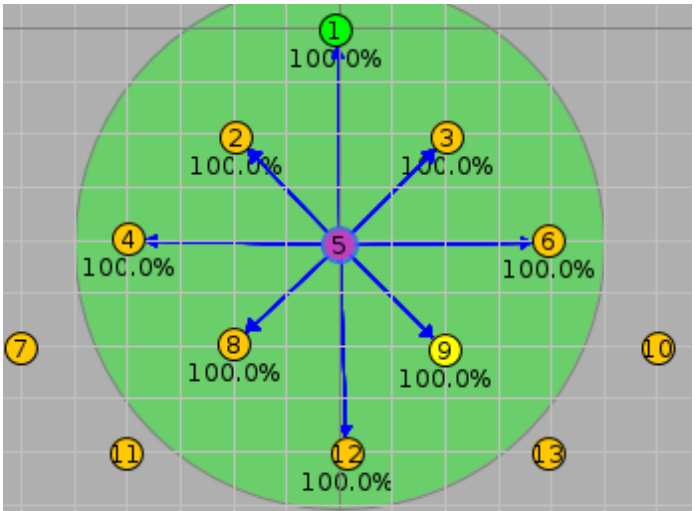
Figure 5. Hello flood attack network topology under IDS detection. Node 1 is the central IDS.